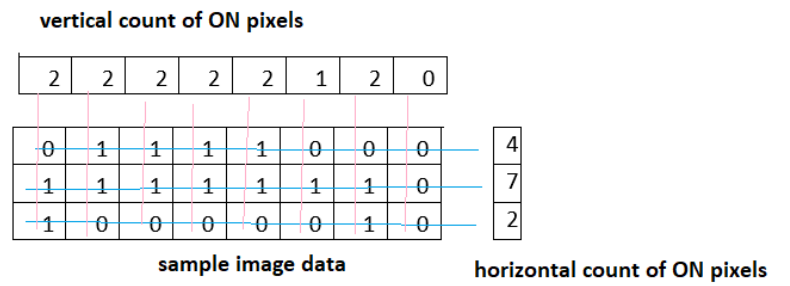
Figure 2. Vertical and horizontal count of pixels.